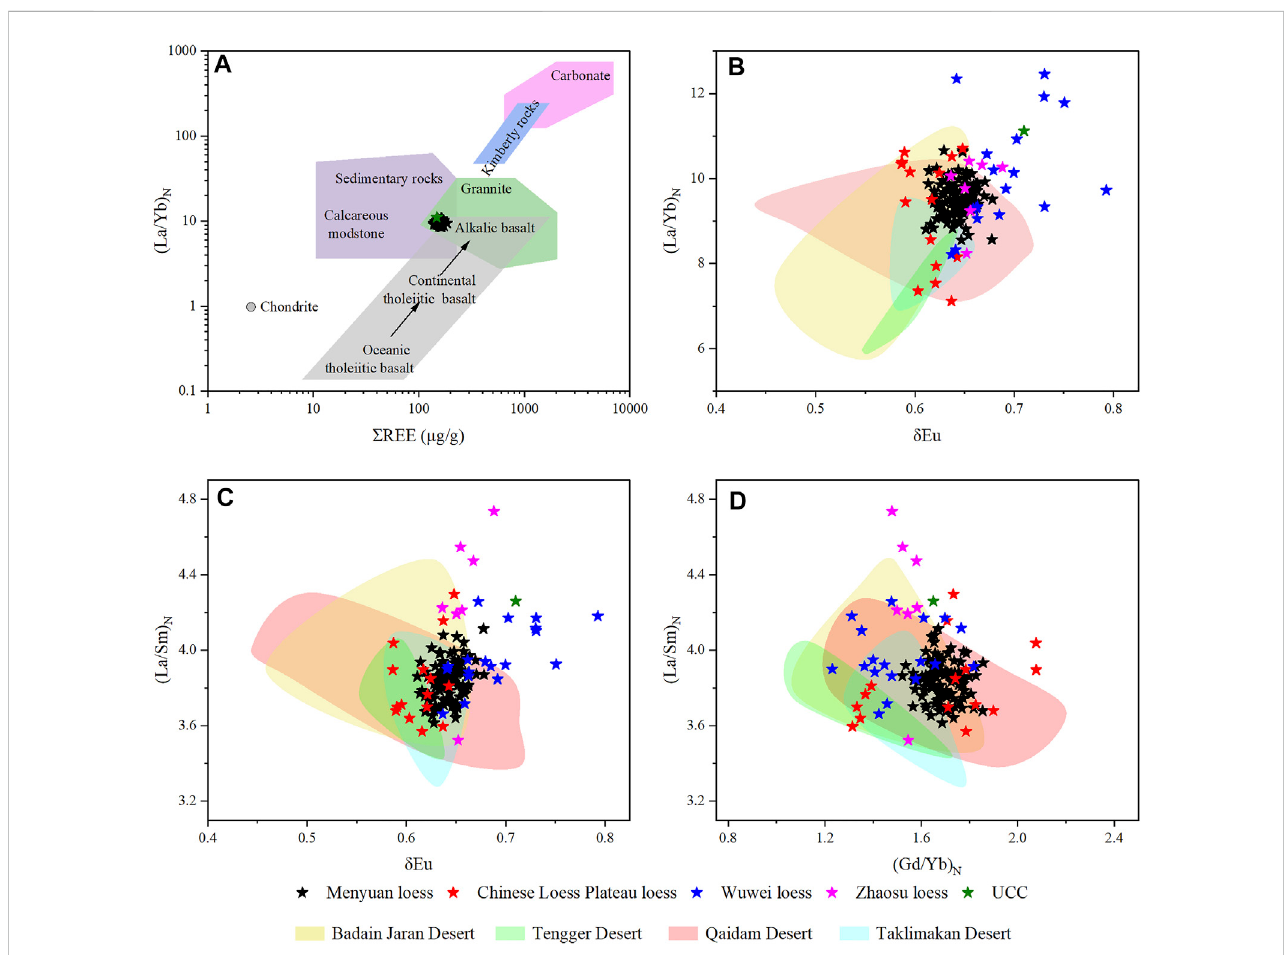
Bivariate diagrams of rare earth elements parameters ratios of samples and their potential source areas. (A) Σ REE vs. (La/Yb) N , from previous work (Liu et al., 2016); (B) δ Eu vs. (La/Yb) N ; (C) δ Eu vs. (La/Sm) N ; (D) (Gd/Yb) N vs. (La/Sm) N